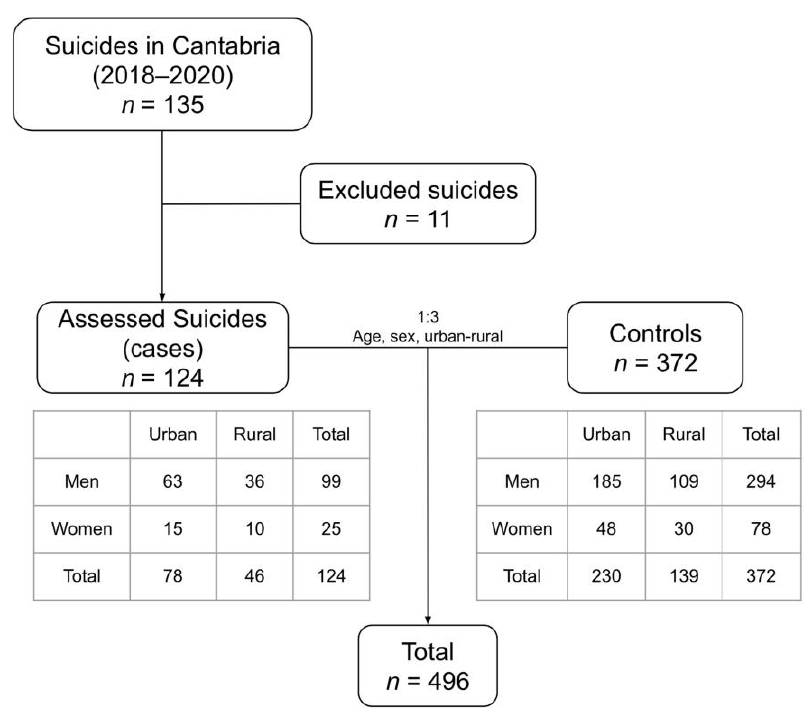
Figure 1. Diagram of study subject selection.